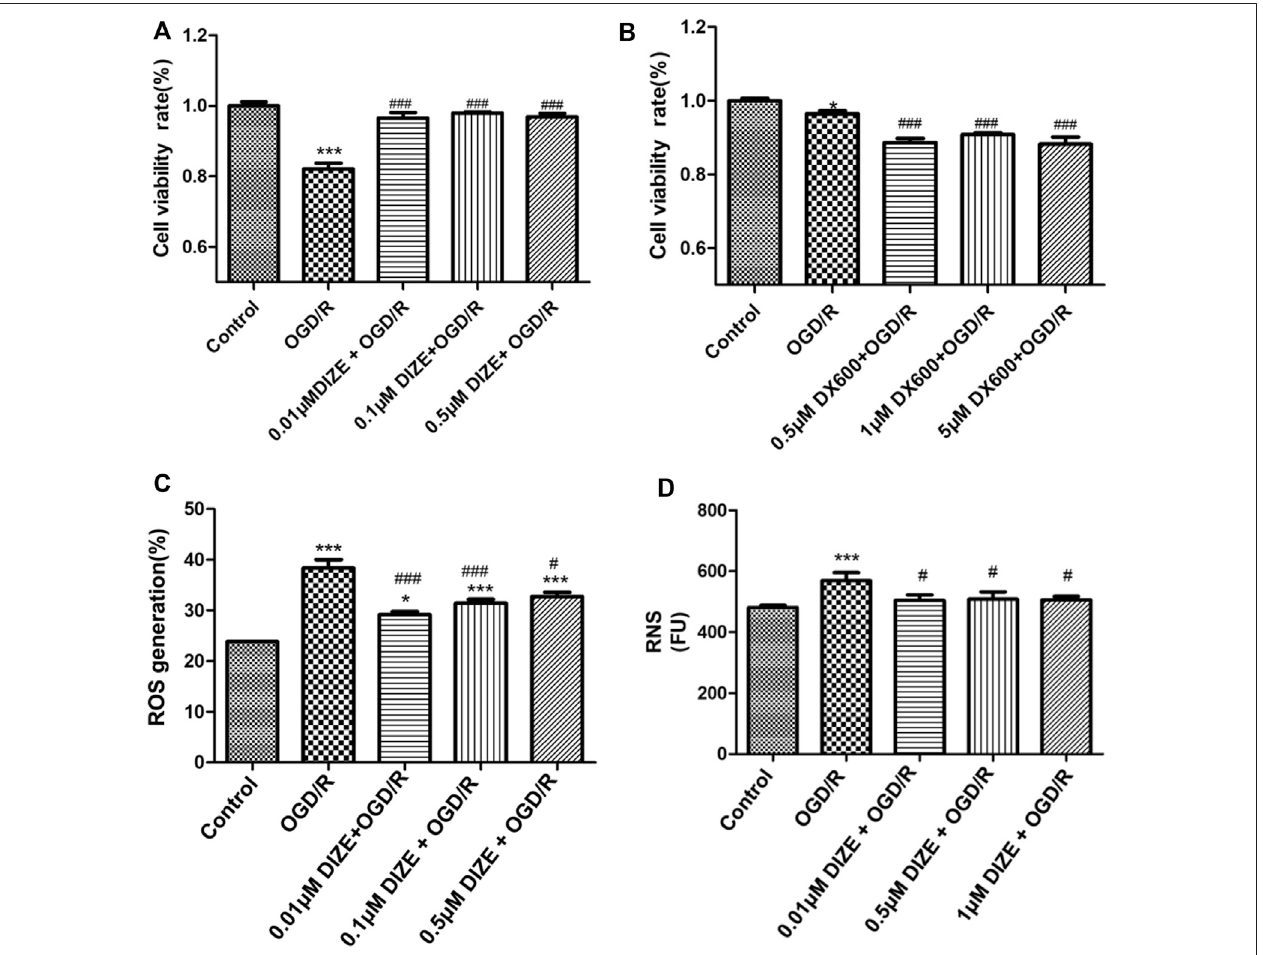
FIGURE 8 | DIZE protected human pulmonary epithelial cell against OGD/R injury. (A) Cell viability was measured via CCK-8 assay. A549 cells were pre-treated withDIZE(0.01,0.1,0.5 μ M)for24 h,andexposedtooxygen-glucosedeprivation(OGD)for8 h,followedbyreperfusionperiod for12 h (B) DX600wasapotentACE2- speci fi c inhibitor. A549 cells were pre-treated with DX600 (0.5, 1, 5 μ M) for 24 h, and exposed to OGD for 8 h, followed by reperfusion period for 12 h. ACE2 inhibition could worsen OGD/R injury to human pulmonary epithelial cells. (C) DIZE alleviated intracellular reactive oxygen species (ROS) production during OGD/R injury in A549. (D) DIZEalleviatedintracellularreactivenitrogenspecies(RNS)productionduringOGD/RinjuryinA549.* p < 0.05,*** p < 0.001 vs. Controlgroup ; # p < 0.05, ## p < 0.01, ### p < 0.001 vs. OGD/R group